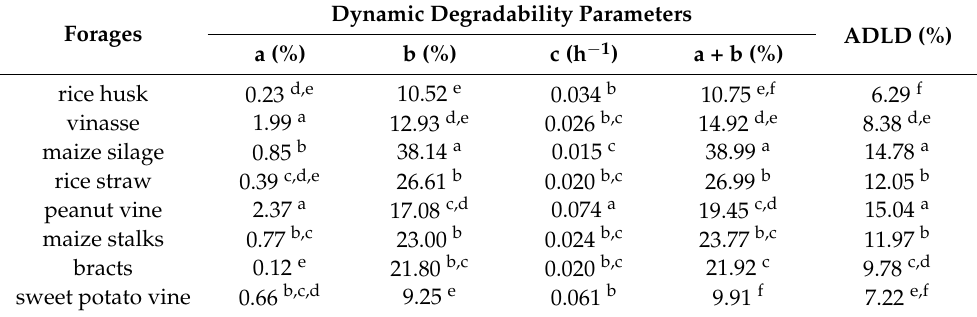
Table 3. The effective degradability of acid detergent lignin (ADLD) in nylon bags of 8 kinds of